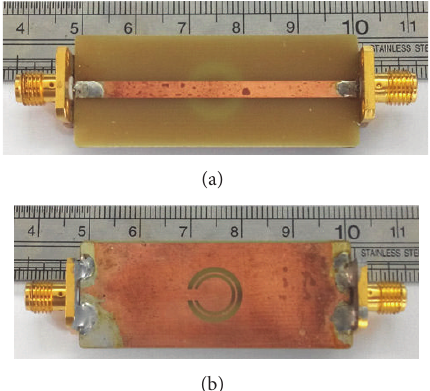
Figure 2: The fabricated microstrip filter with DGS. (a) Top view; (b) bottom view.